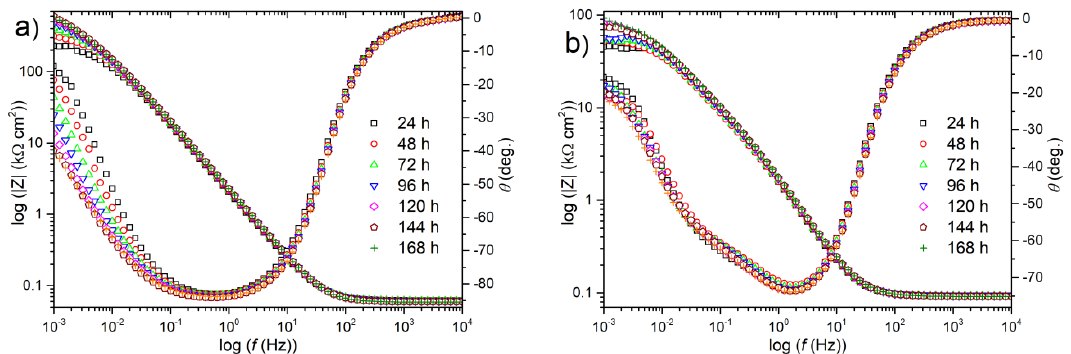
Figure 7. Bode representation of the impedance spectra recorded for ( a ) blank and ( b ) composite Ni coatings for 168 hours exposure in 0.05 M NaCl solution.